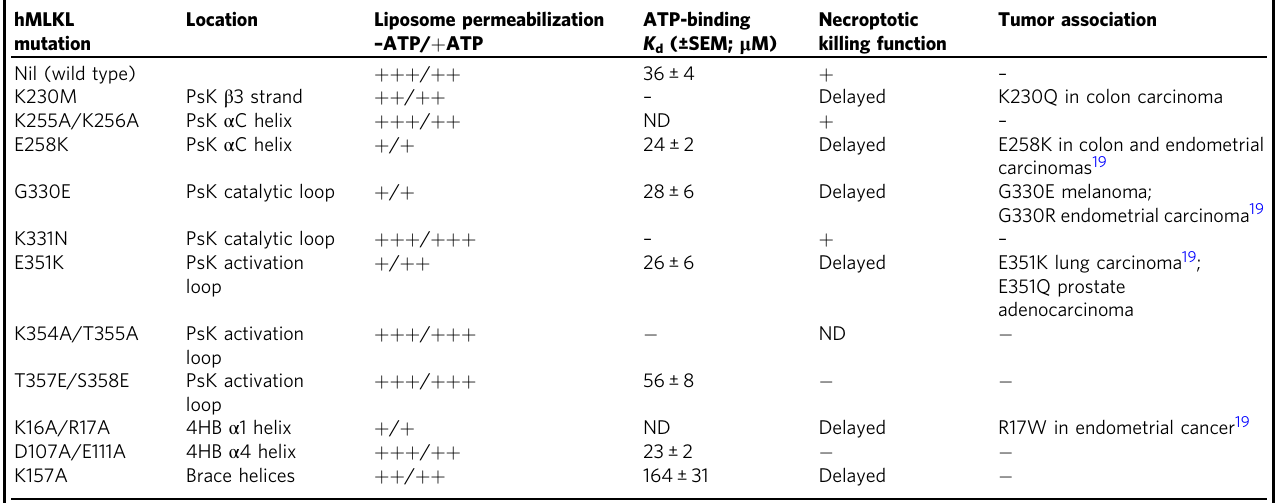
Table 1 Summary of wild-type and mutant hMLKL properties hMLKL